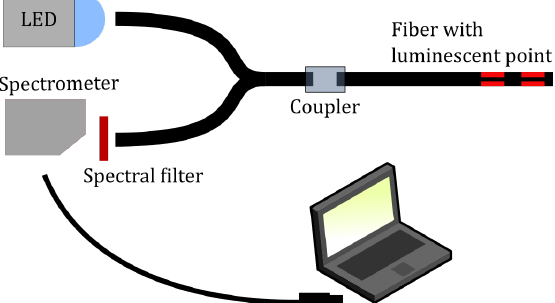
Figure 4. Experimental setup. Light from an LED (470nm) is coupled into a 1mm POF splitter (acquired from FiberFin). The light is guided into a sample fiber with the photoluminescent annular cavities via an SMA coupler. The light returning will be guided back into the splitter, and some of it will travel to the spectrometer. Before entering the spectrometer, the light passes through a spectral filter, removing the LED excitation wavelength. The spectra are acquired via a